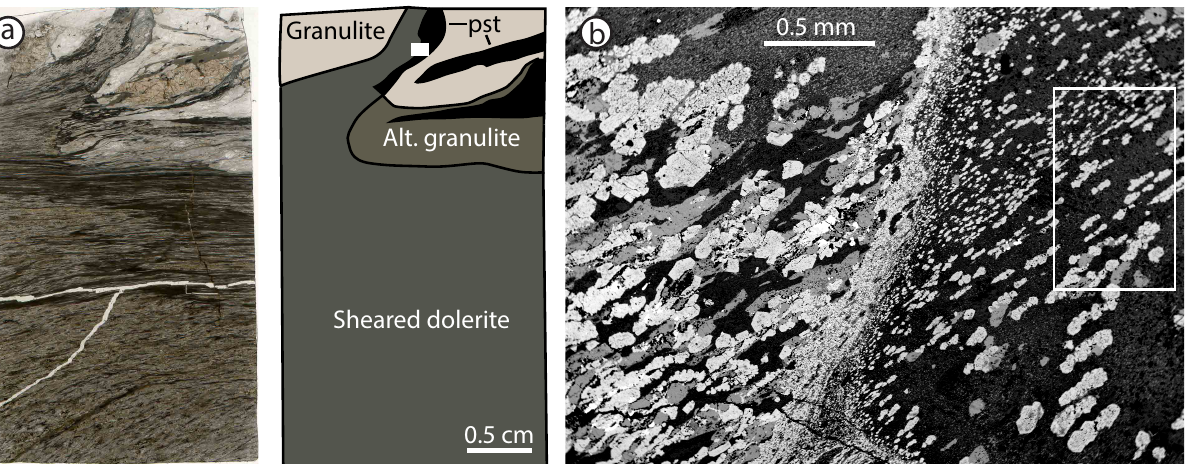
Figure A1. Microstructural context of area mapped in sample S5 (Fig. 8): (a) plane polarized light microscopic image and sketch of the thin section, with the box indicating the image in (b) . (b) BSE image of the boundary between dolerite (left) and sheared pseudotachylyte, with the white box indicating area in Fig. 8a.